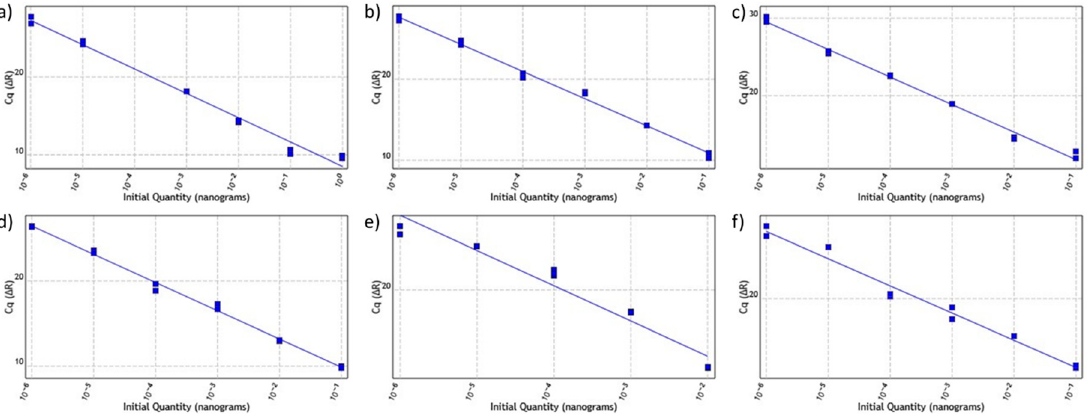
Figure 4. Standard curves of ATP1, COX2, GAPDH, MATK, NADH and RPOB gene primers : (a) ATP1 ; (b) COX2 ; (c) GAPDH ; (d) MATK ; (e) NADH ; (f) RPOB .